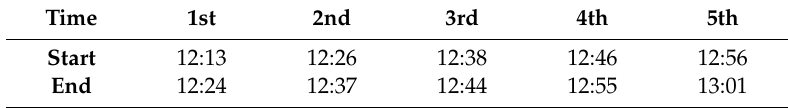
Figure 8. ADCP velocity data with vector plots along the tracks. ( a ) five ADCP ship tracks. ( b ) Vector plots for ADCP velocity.